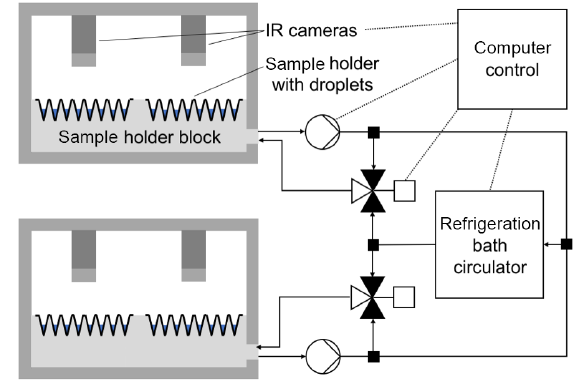
Figure 3. Schematic illustration of the overall setup: sample holder blocks, sample holders with droplets, IR cameras, cooling system with refrigeration bath circulator, pumps and mixing valves, com- puter